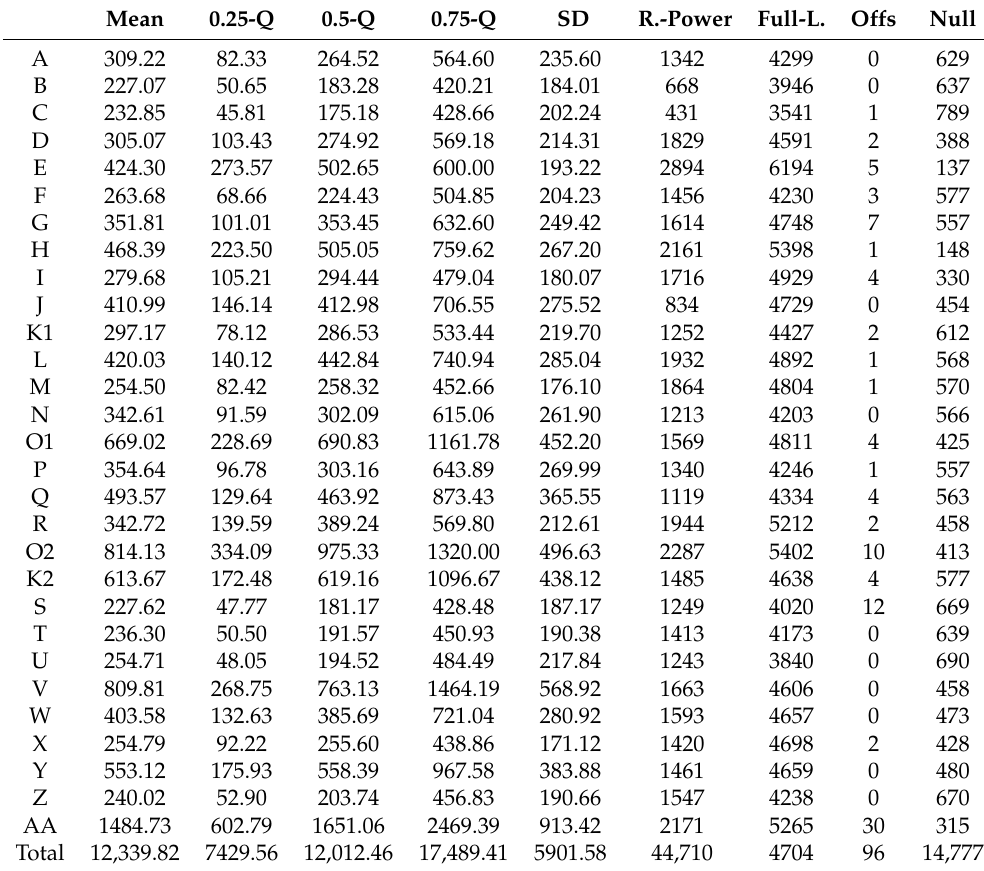
Table 2. Descriptive statistics of wind farms in